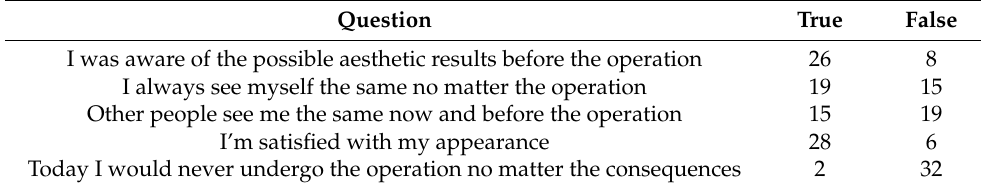
Table 5. Aesthetic satisfaction of the study group.